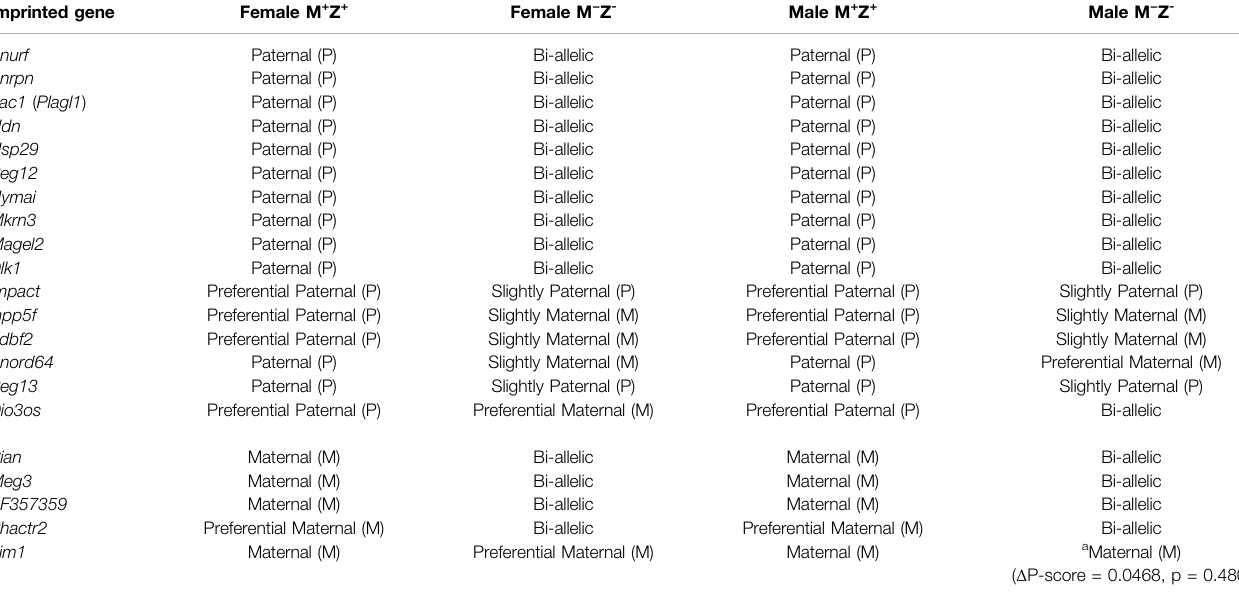
TABLE 1 | Allelic expression switch was observed for some imprinted genes lacking Zfp57 . Imprinted